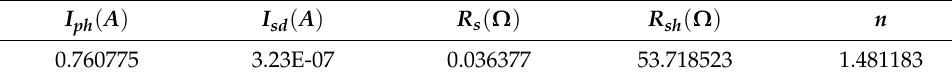
Table 1. Depiction of an initial solution for SDM.